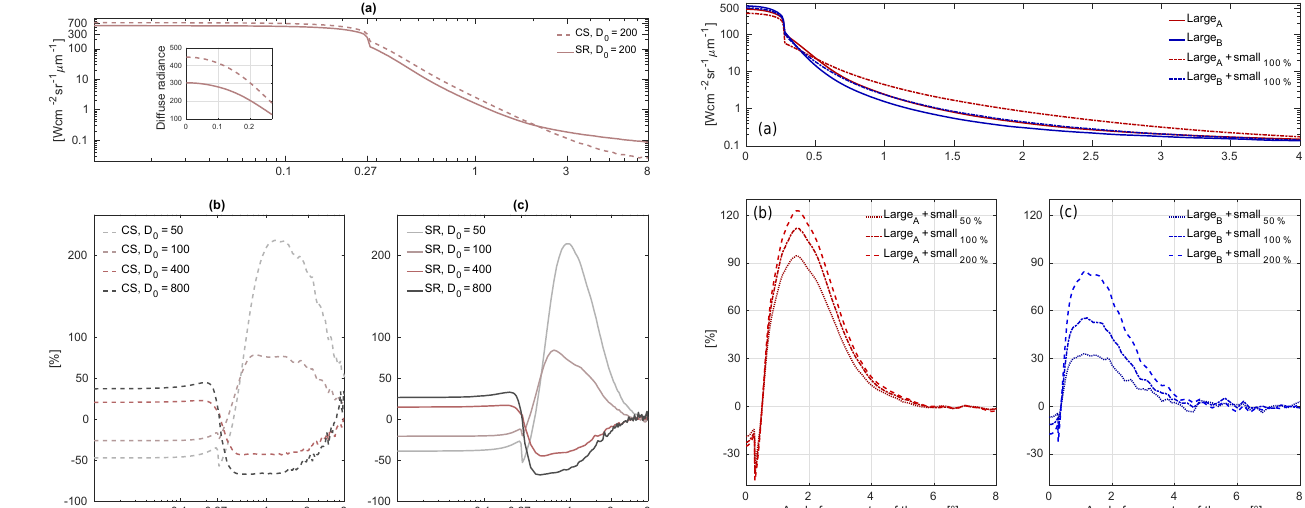
the observed concentration of small ice crystals, respectively.